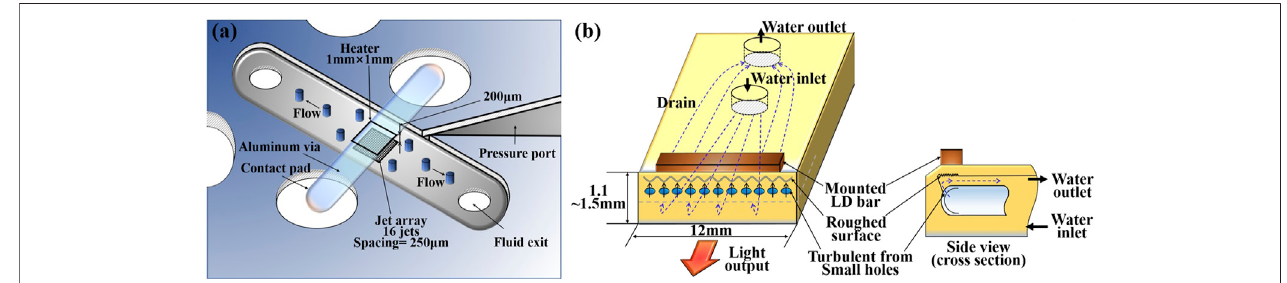
FIGURE 11 | (A) Schematic diagram of nozzle structure of jet impact device suitable for laser heat dissipation. Adapted from [53]; (B) Schematic diagram of a device that combines water-cooling heat dissipation and jet impact heat dissipation. Adapted from